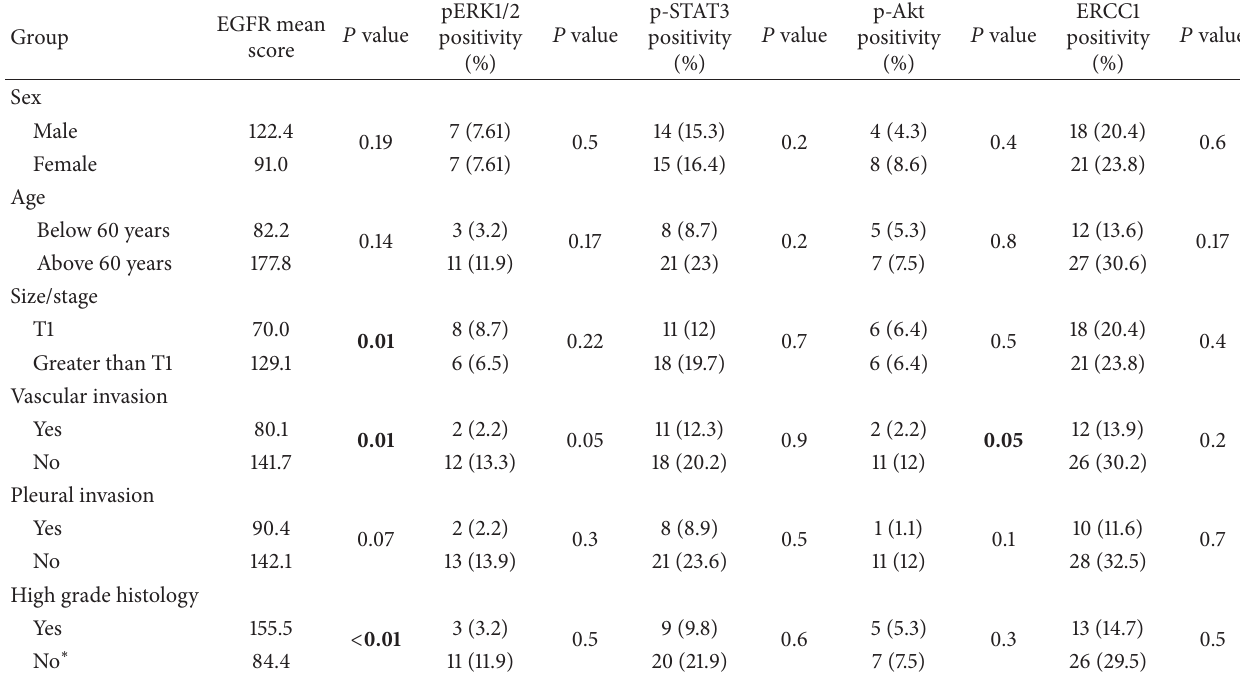
Table 2: Expression of EGFR, p-ERK1/2, p-STAT3, ERCC1, and Akt by immunohistochemistry, and clinicopathological characteristics in 96 patients with lung